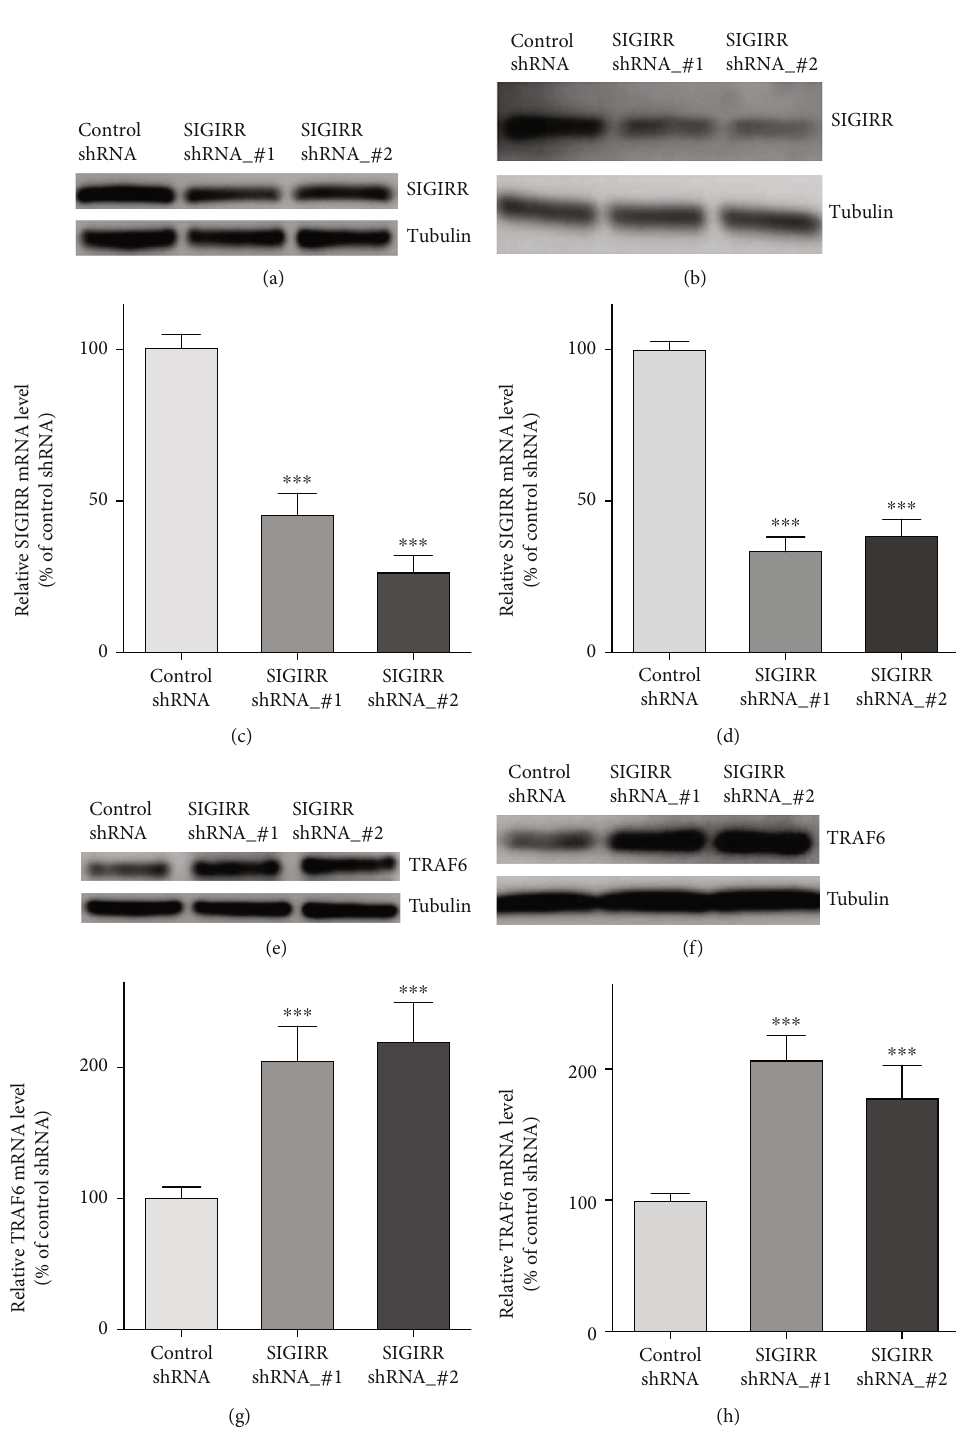
Figure 2: E ff ect of SIGIRR on TRAF6 expression both in AECs and in AMCs. (a, b) The results using western blot demonstrated that SIGIRR expression was reduced signi fi cantly both in AECs and in AMCs after transfection with SIGIRR_shRNA#1 or SIGIRR_shRNA#2. (c, d) The results using quantitative PCR demonstrated that SIGIRR mRNA levels were reduced signi fi cantly in AECs and AMCs after the above transfection. (e, f) TRAF6 expression by using western blot obviously increased in SIGIRR_shRNA-treated cells compared with those in control cells both in AECs and in AMCs. (g, h) TRAF6 mRNA levels by using quantitative PCR obviously increased in SIGIRR_shRNA- treated cells compared with those in control cells both in AECs and in AMCs. The data represent three independent experiments with four samples for each treatment. ∗∗ P < 0 : 01 and ∗∗∗ P < 0 : 001